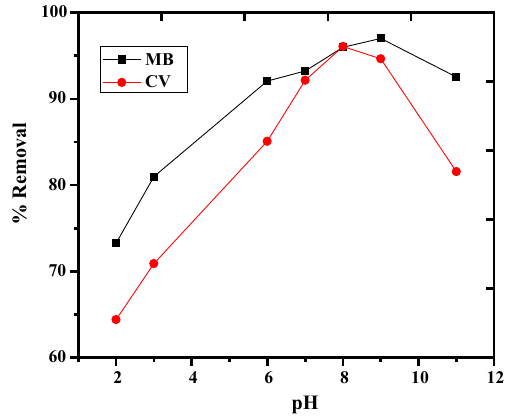
Fig. 6 The influence of pH on the removal efficiency of CV and MB by MSH